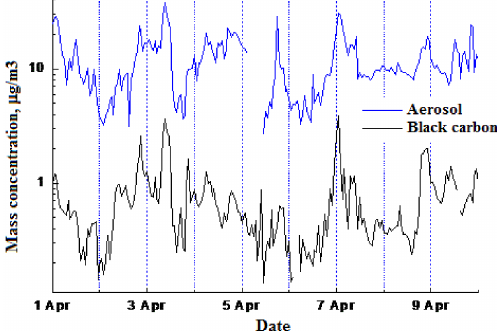
Figure 6. Altitude profiles of (a) refractive and absorption indices of dry aerosol base and (b) relative black carbon content during the flight on 30 July 2013 in the region of Zavyalovo settlement. Figure 7. Time variations in the mass concentrations of dry base of submicron aerosol and black carbon during 1–9 April